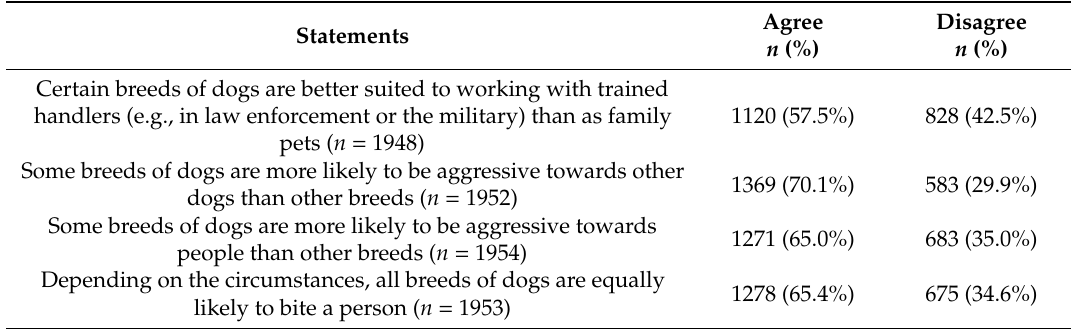
Table 2. Perceived association between dog breed and